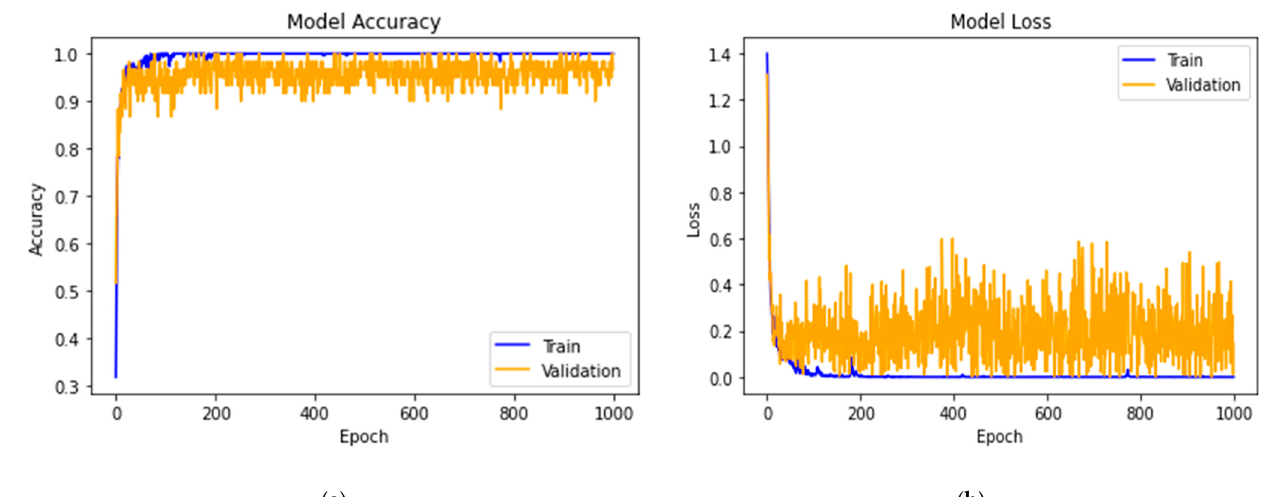
Figure 3. ( a ) Accuracy and ( b ) loss of the proposed 14-DCNN model.